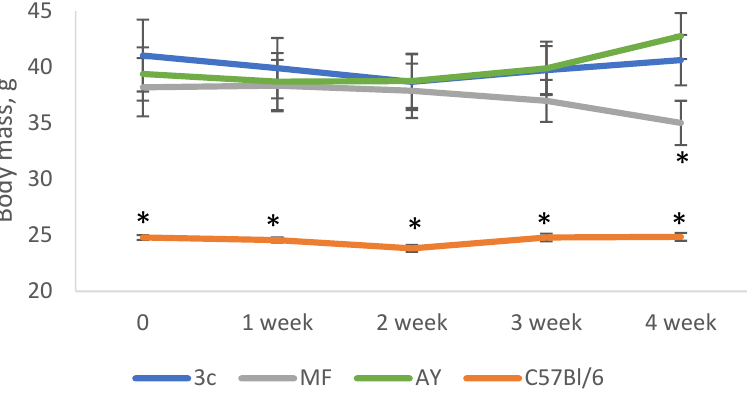
Figure 2. Body mass change during the experiment. * p < 0.05 as compared to AY mice. The dynamics of feed consumption by mice in all experimental groups differed from each other (Table 2). A decrease in this index was noted in animals receiving MF. The